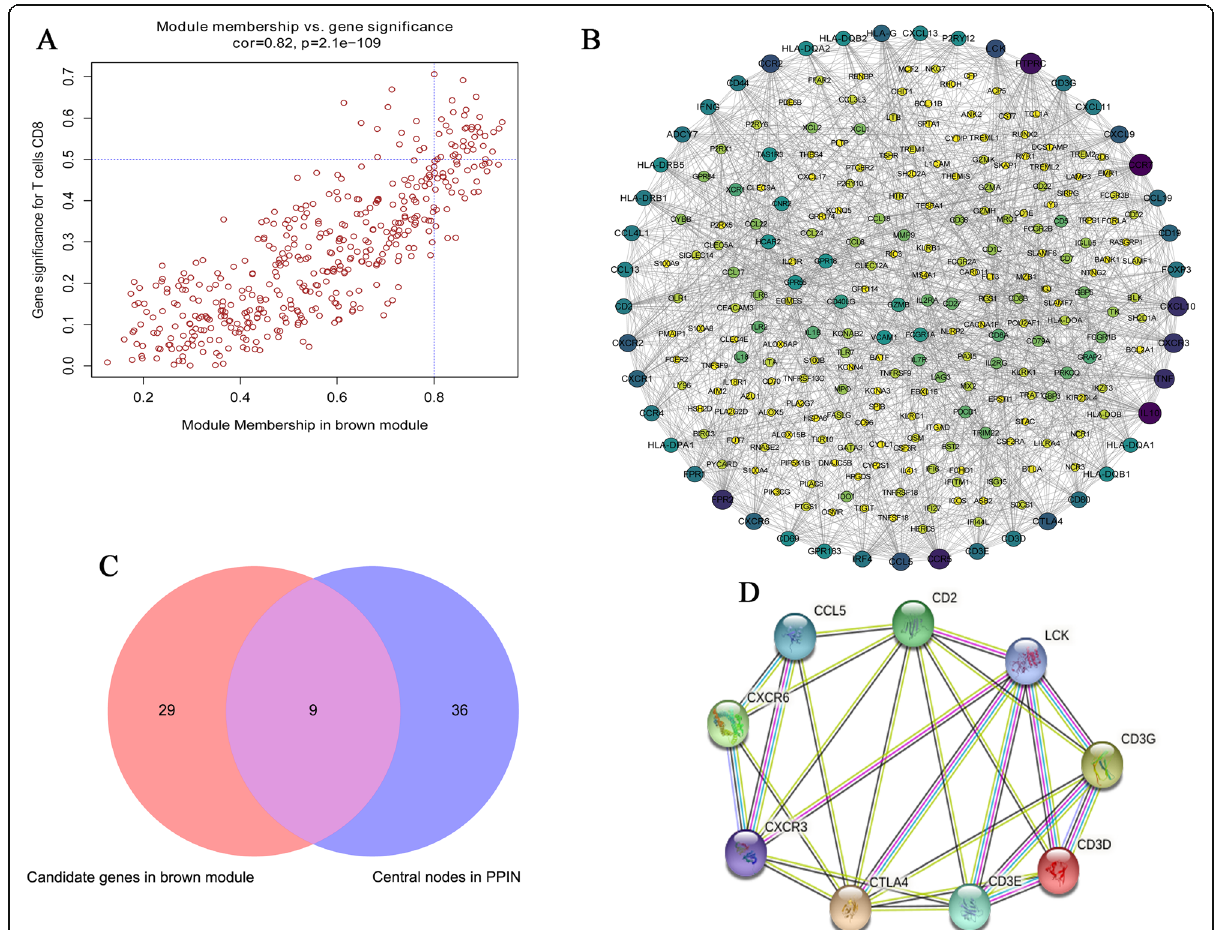
Fig. 4 Identification of hub genes. A Scatter diagram of genes in brown module. Each red circle represents a gene. B PPI network of all genes in the hub module. The outermost circle is the center node. C Overlapping genes between the PPI network and scatter diagram (module connectivity > 0.8 and clinical trait relationship > 0.5) were selected as hub genes. D PPI network of the 9 hub genes. PPI, protein-protein